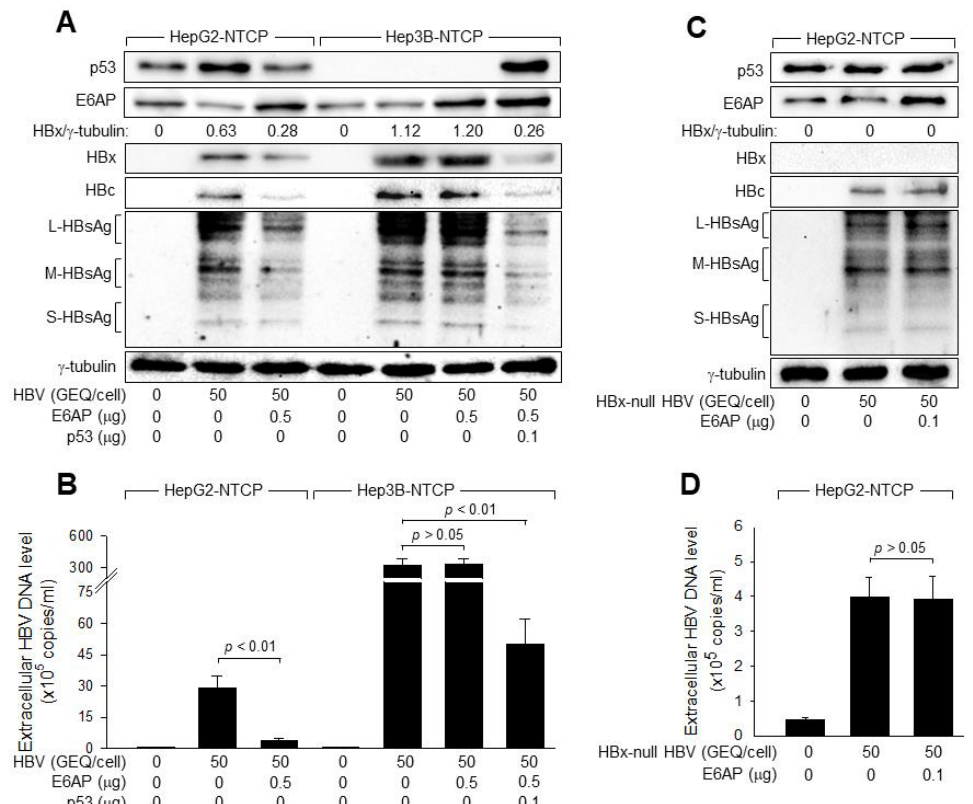
Figure 9. p53 inhibits HBV replication via the E6AP-mediated proteasomal degradation of HBx. ( A ) HepG2-NTCP and Hep3B-NTCP cells were transfected with the indicated amounts of E6AP and p53 expression plasmids for 24 h and either mock-infected or infected with HBV at 50 GEQ/cell for an additional 4 days. ( B ) Levels of HBV particles released from the cells prepared in ( A ) were determined by qPCR ( n = 5). ( C ) HepG2-NTCP cells were transfected with an empty vector or E6AP expression plasmid for 24 h and either mock-infected or infected with HBx-null HBV at 50 GEQ/cell for an additional four days. ( D ) Levels of HBV particles released from the cells prepared in ( C ) were determined by qPCR ( n = 5).